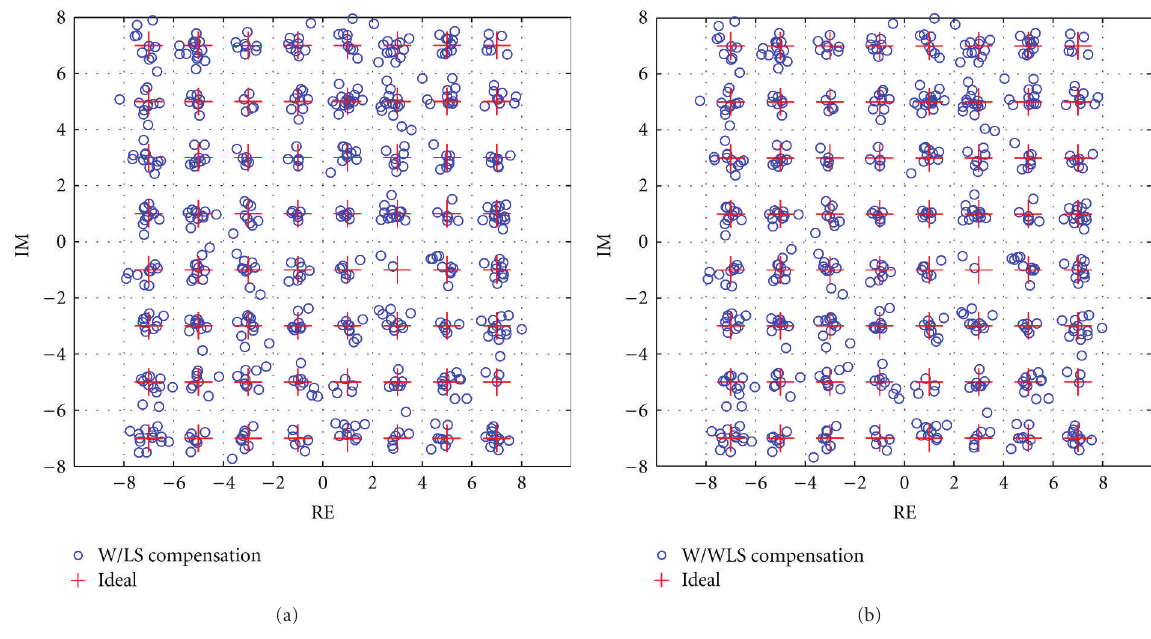
Figure 19: Measured constellation diagram of 64-QAM OFDM system with RF impairments mitigation. (a) Compensated with LS method (b) Compensated with WLS